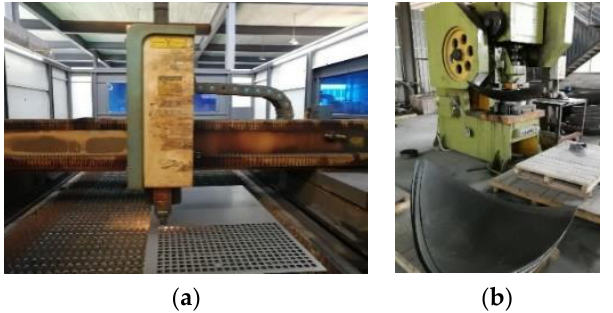
Figure 3. Method of laser cutting, stamping and welding. ( a ) Laser cutting, ( b ) stamping.